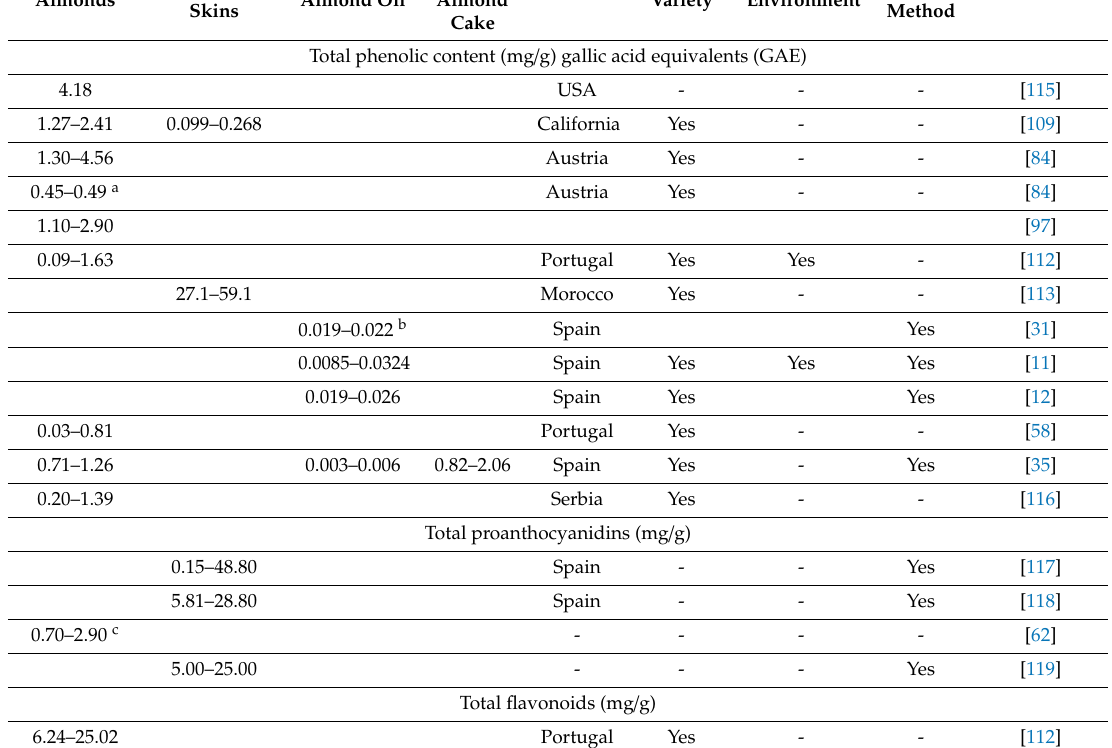
Table 5. Total phenolic content (mg / g) gallic acid equivalents (GAE), total proanthocyanidins (mg / 100 g) and total flavonoids (mg / 100 g) in almonds, almond oil and defatted almond cake. Range of Means Origin Variability Sources Defatted Almond Almond Oil Almond Skins Cake